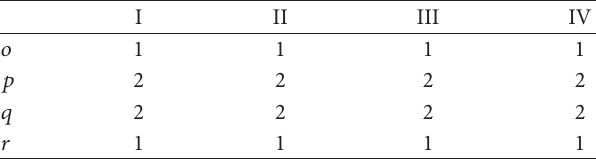
Table 4: Important rankings of nodes in different